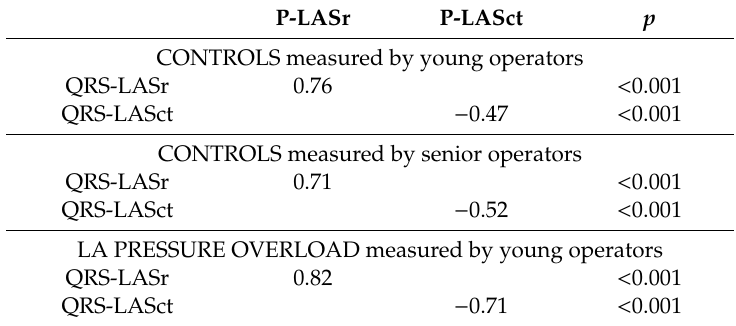
Table 5. Values of r coe ffi cients for the correlation between indices of LA reservoir function (QRS-LASr and P-LASr) and of LA contraction (QRS-LASct and P-LASct). P-LASr